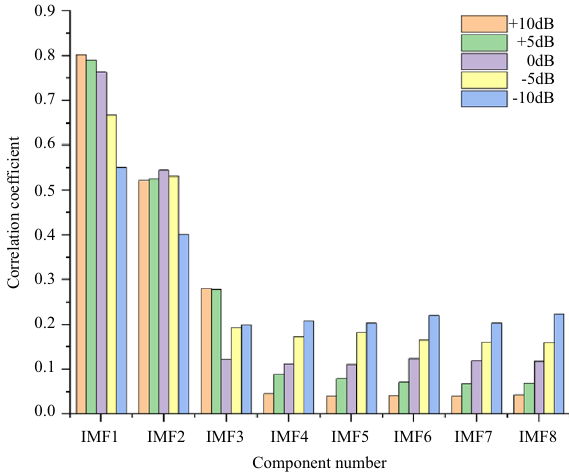
Figure 8. Correlation coefficients corresponding to different IMFs.